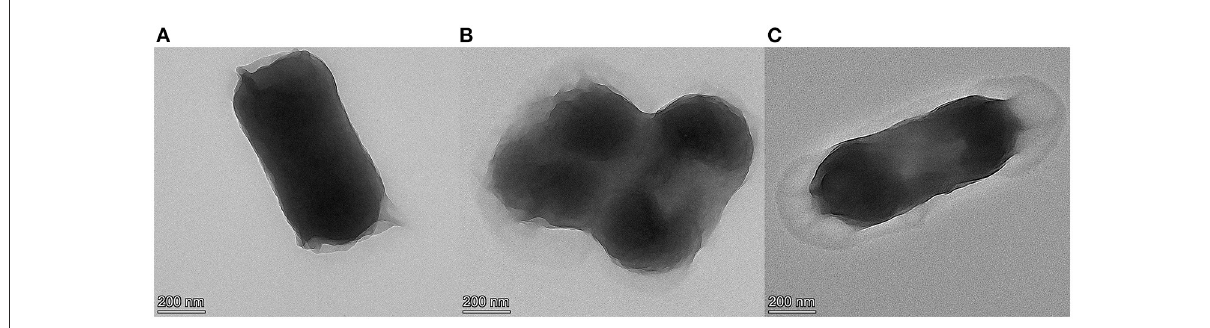
FIGURE1 TEM micrographs of E. coli, untreated (A) , treated with cinnamaldehyde at MIC (B) , treated with cinnamaldehyde at 2MBC (C) .